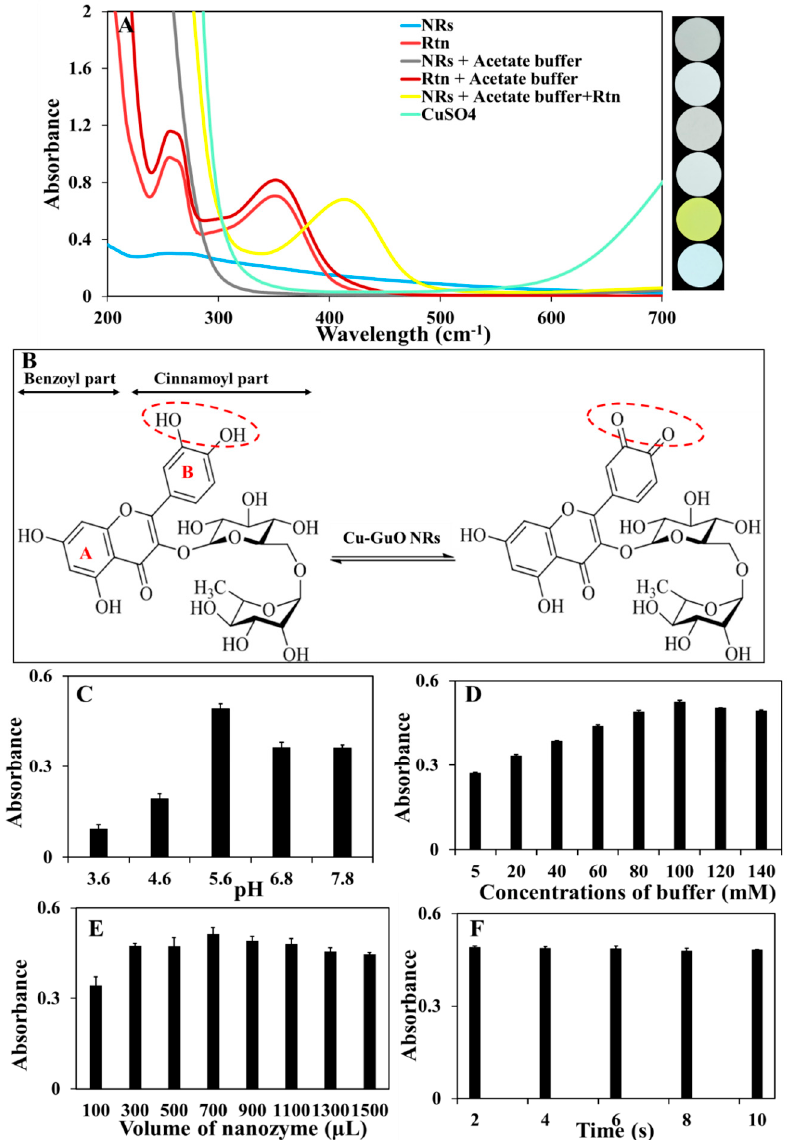
Figure 3. ( A ) UV–Vis spectra of the different solutions: 700 µ L of Cu-Guo NRs (1 mg mL − 1 ), Rtn (46.68 µ M), 700 µ L of Cu-Guo NRs (1 mg mL − 1 ) in the presence of acetate buffer (100 mM, pH of 5.6); Rtn (46.68 µ M) in the presence of acetate buffer (100 mM, pH of 5.6); Rtn (46.68 µ M) in the presence of acetate buffer (100 mM, pH of 5.6); and 700 µ L of NRs (1 mg mL − 1 ) and CuSO 4 (800 µ M) with their corresponding images (from top to down). ( B ) The proposed possible sensing strategy of Rtn based on the catalytic oxidation reaction by Cu-Guo NRs. The effect of the ( C ) buffer type in a solution containing acetate buffer (100 mM) with different pH values of 3.6, 4.6, and 5.6 and HEPES buffer (100 mM) with different pH values from 6.8 to 7.8, in the presence of Rtn (46.68 µ M) and 700 µ L of Cu-Guo NRs (1 mg mL − 1 ). ( D ) Buffer concentration in a solution containing acetate buffer (pH of 5.6) with different concentrations from 5 mM to 140 mM, Rtn (46.68 µ M) and 700 µ L of Cu-Guo NRs (1 mg mL − 1 ). ( E ) Nanozyme volume in a solution containing 100 mM of acetate buffer (pH of 5.6) and various volumes of Cu-Guo NRs from 100 µ L to 1500 µ L and Rtn (46.68 µ M). ( F ) Reaction time from 2 min to 10 min for a solution containing 100 mM of acetate buffer (pH of 5.6) and Rtn (46.68 µ M) and 700 µ L of Cu-Guo NRs (1 mg mL − 1